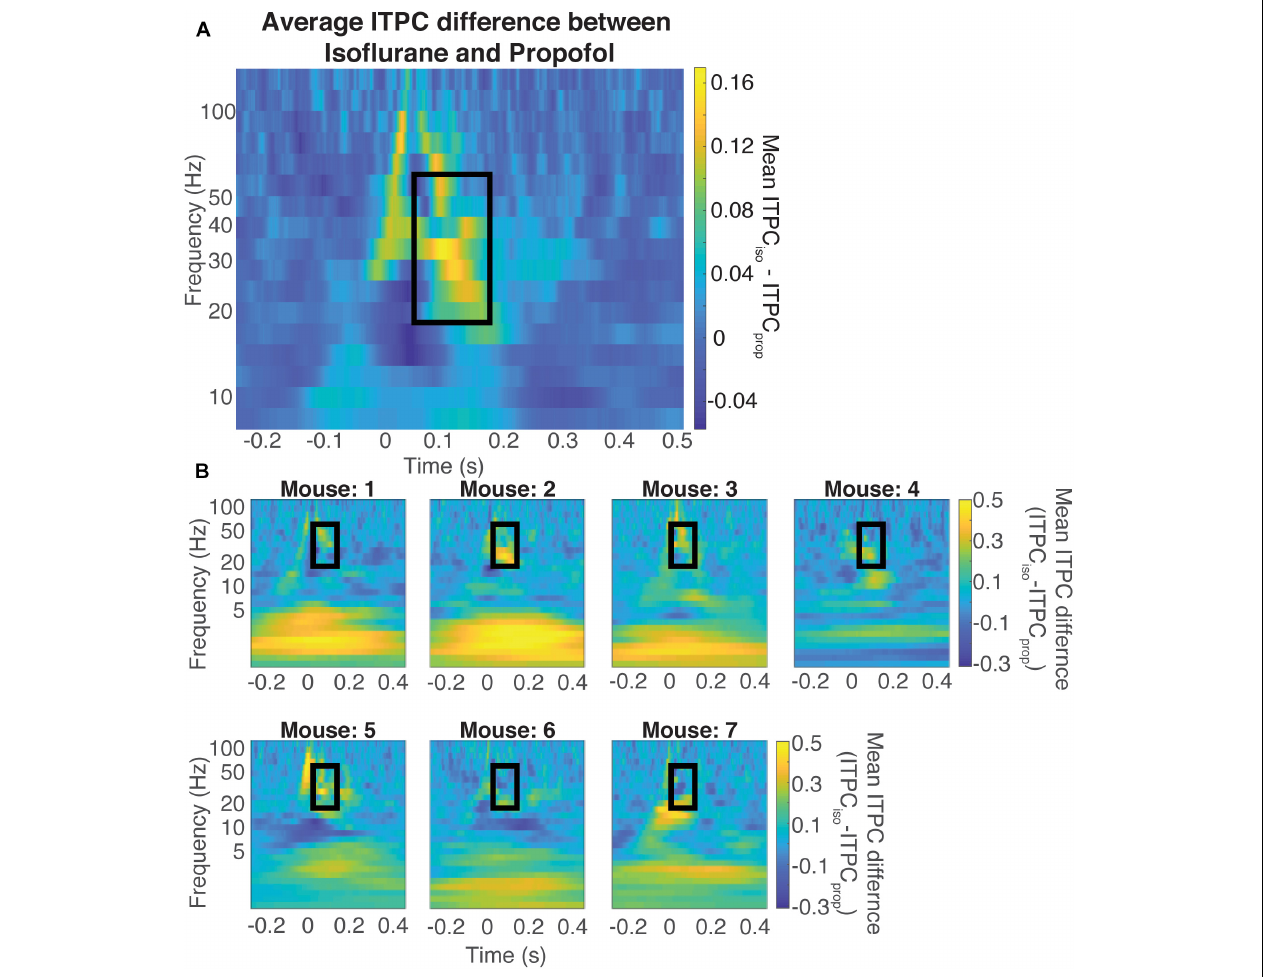
FIGURE 7 | Difference in coherence is in the evoked gamma band. Average difference between the ITPC under both doses of isoflurane and propofol (A) Yellow colors represent higher ITPC under isoflurane while dark blue colors represent higher ITPC under propofol. The maximum difference in evoked coherence occurs within the black rectangle, at 80 ms after stimulus onset and is centered at 36 Hz. The Quantification of the ITPC in the gamma range (20–60 Hz) within the black rectangle yields a significant difference between the gamma coherence of visual evoked responses (timepoints = 900, p < 0.000001, Mann–Whitney U -test). Individual difference between the ITPC under both doses of isoflurane and propofol (B) . Yellow colors represent higher ITPC under isoflurane while dark blue colors represent higher ITPC under propofol. The Quantification of the ITPC in the gamma range (20–60 Hz) within the black rectangle yields a significant difference between the gamma coherence of visual evoked